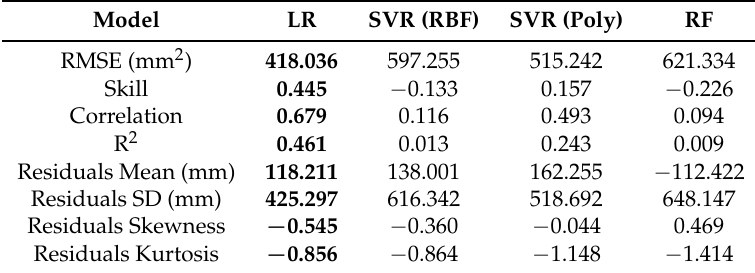
Table 4. Performance of each of the autumn precipitation models on the testing data set (2011–2019), similar to Table 3.